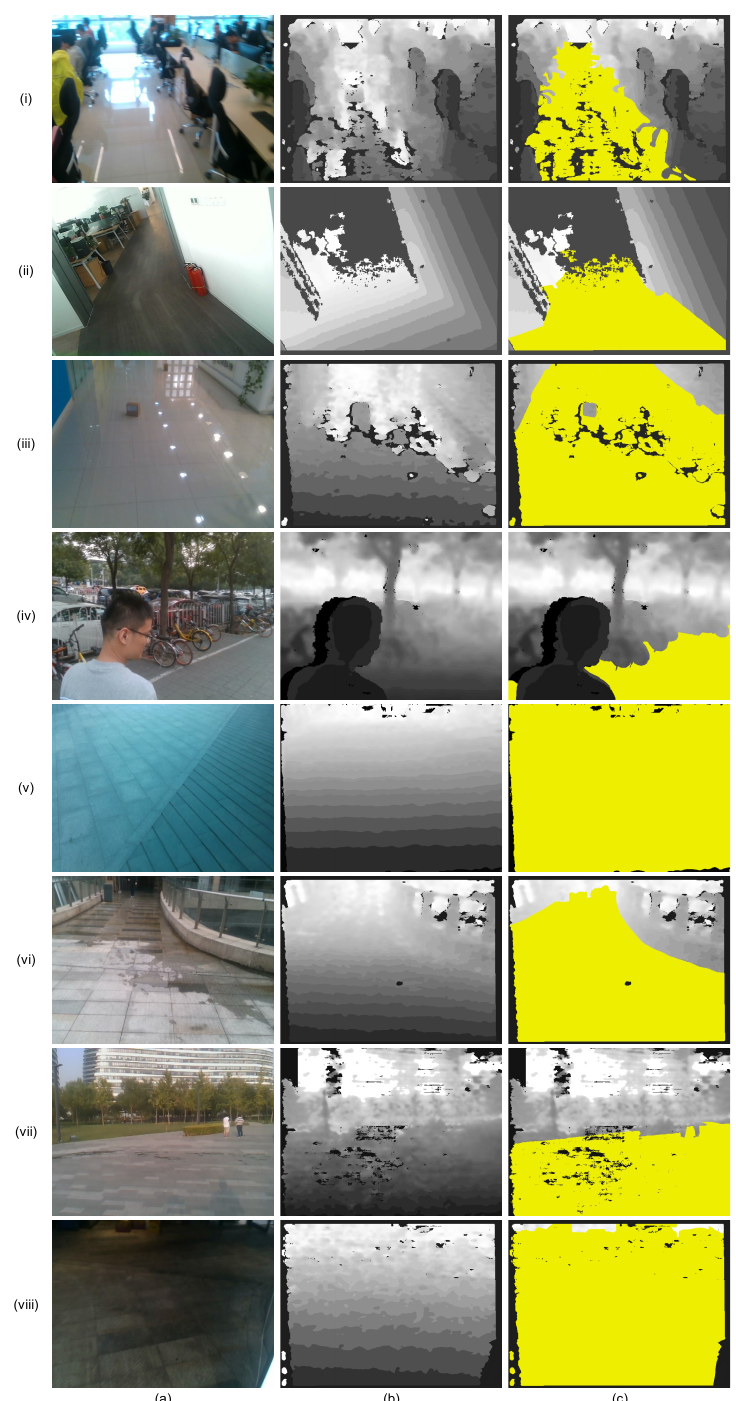
Figure 10. Labeled samples of the ground in indoor and outdoor environment. ( a ) RGB image, ( b ) depth image, ( c ) ground truth of ground segmentation (the yellow region is the ground truth of the ground). ( i – iii ) indoor environment, ( iv – viii ) outdoor environment. ( i ) floor with reflections of sunlight, ( ii ) floor under normal light, ( iii ) floor with reflections of light, ( iv ) ground under normal sunlight, ( v ) ground under strong sunlight, ( vi ) ground after raining, ( vii ) ground before sunset, ( viii ) ground at